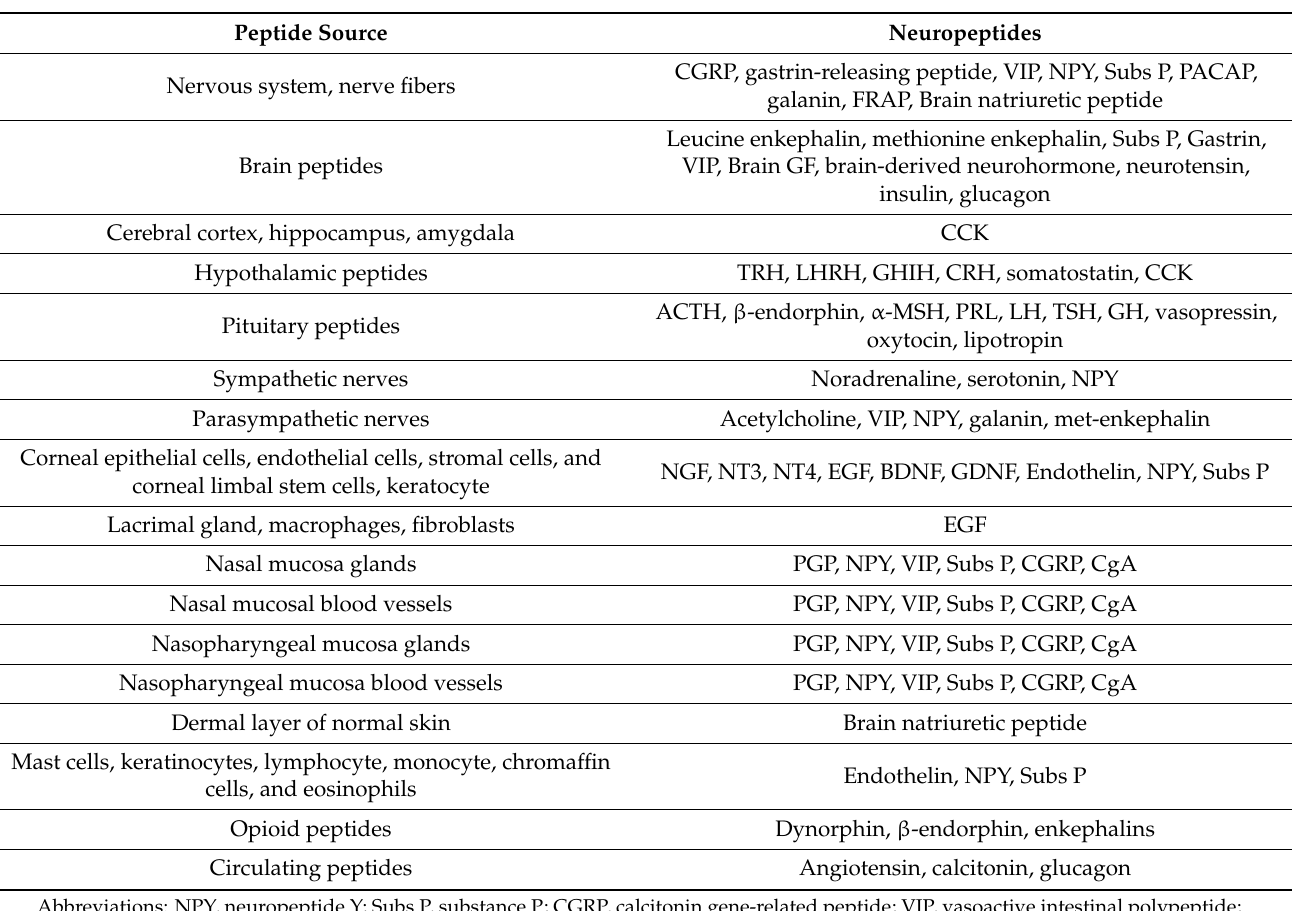
Table 2. Sources of